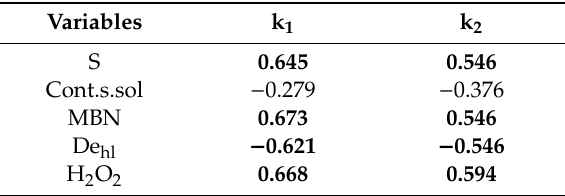
Table 7. Values of correlation coe ffi cients between the characteristics of activated carbons and the kinetic parameters (pseudo-first / second order) for crystal violet.